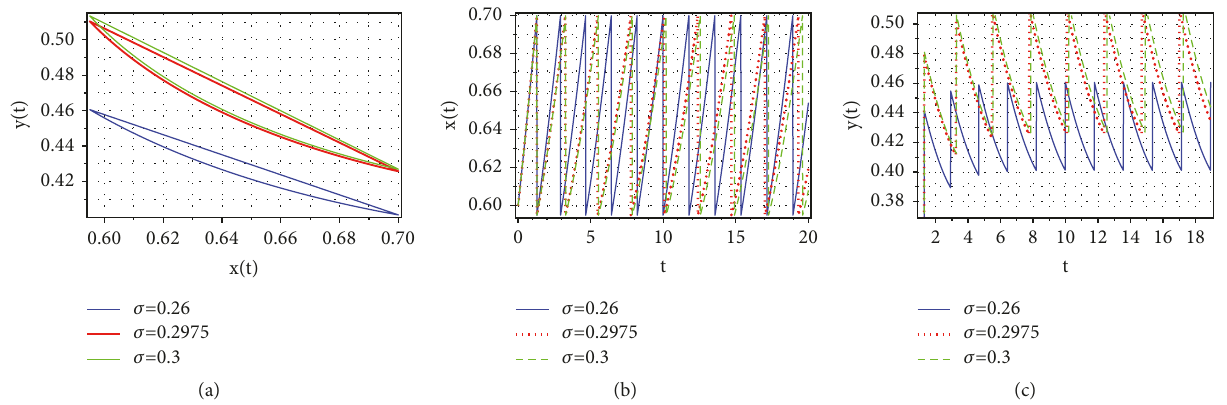
Figure 6: Numerical simulations in case 0 < ℎ 1 < ℎ < min {𝑥 ∗ , ℎ 2 } . (a) Phase portrait of 𝑥(𝑡) and 𝑦(𝑡) on ℎ = 0.7 . (b) Time series of 𝑥(𝑡) . (c) Time series of 𝑦(𝑡) .